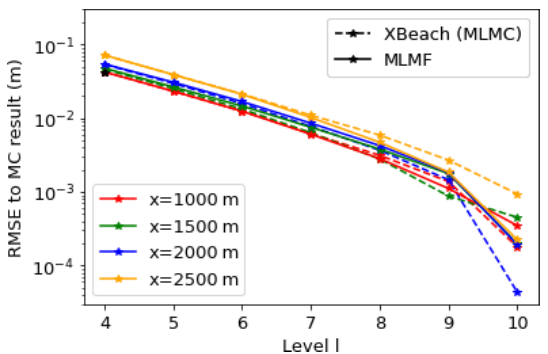
Figure 7. Error (RMSE) between the MLMF result and the Monte Carlo (MC) result for the analytical estimate for the final water ele- vation at the locations of interest in the non-breaking wave test case, as the resolution level becomes finer. The x axis indicates the finest level considered by the MLMC and MLMF estimators for that error. Both the error from using MLMF and the error from using MLMC with a single model are shown. Here a tolerance of (cid:15) = 1 × 10 − 3 is chosen in Eqs. (14) and (B7) for MLMF and MLMC respectively.